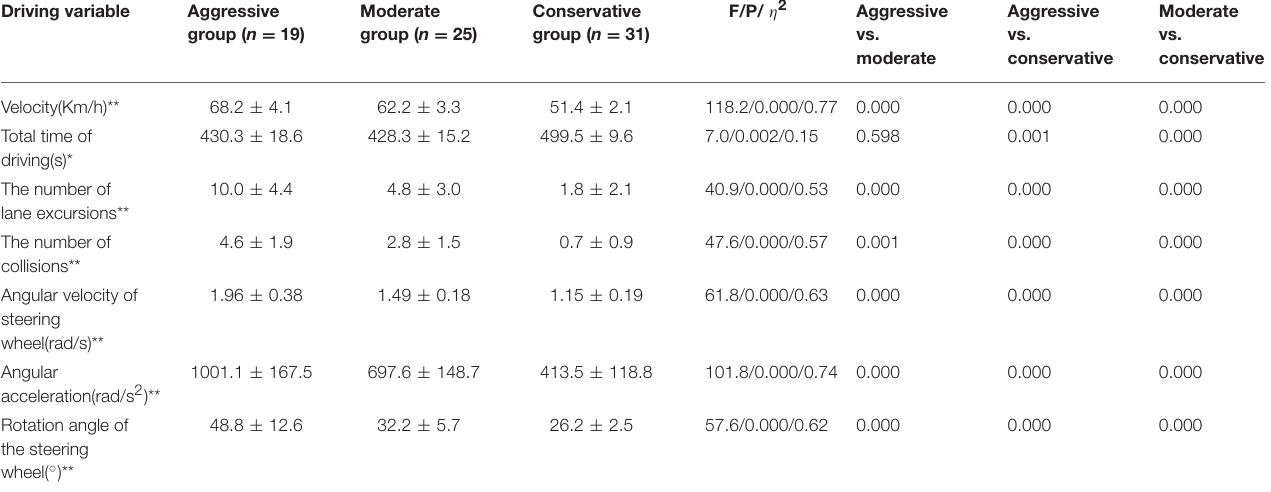
TABLE 1 | Driving variables of the three groups.